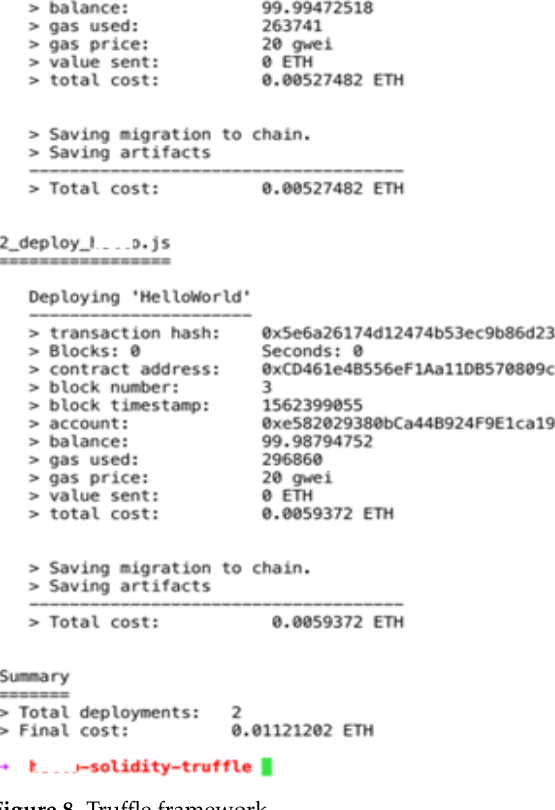
Figure 8. Truffle framework.